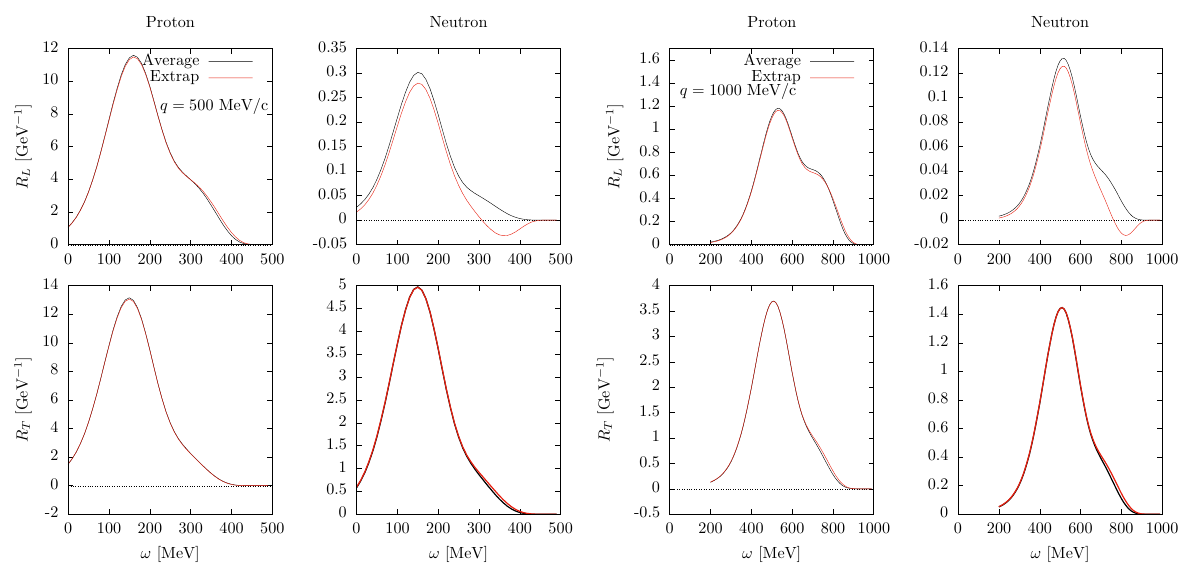
Figure 6. Longitudinal and transverse response functions separated for protons and neutrons in the SuSAM* model using the averaged and extrapolated single-nucleon responses for q = 500 (two left panels) and 1000 MeV/c (two right panels).